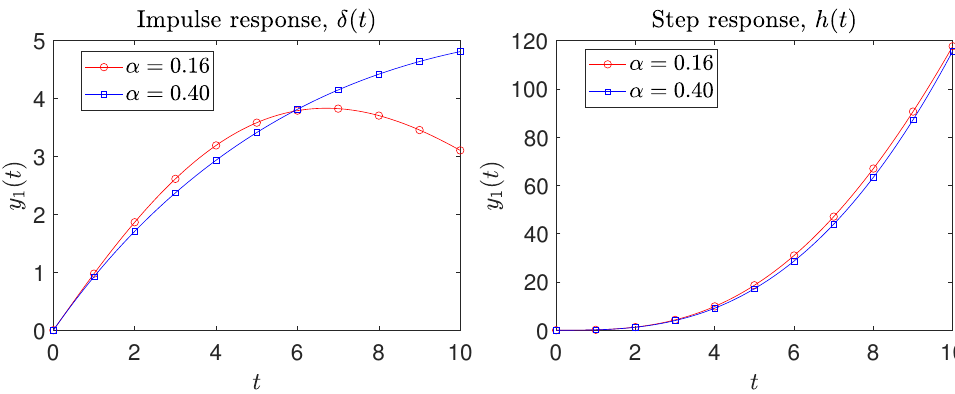
Figure 4. The sensor time responses y 1 ( t ) to the input signals u ( t ) = { δ ( t ) , h ( t ) }